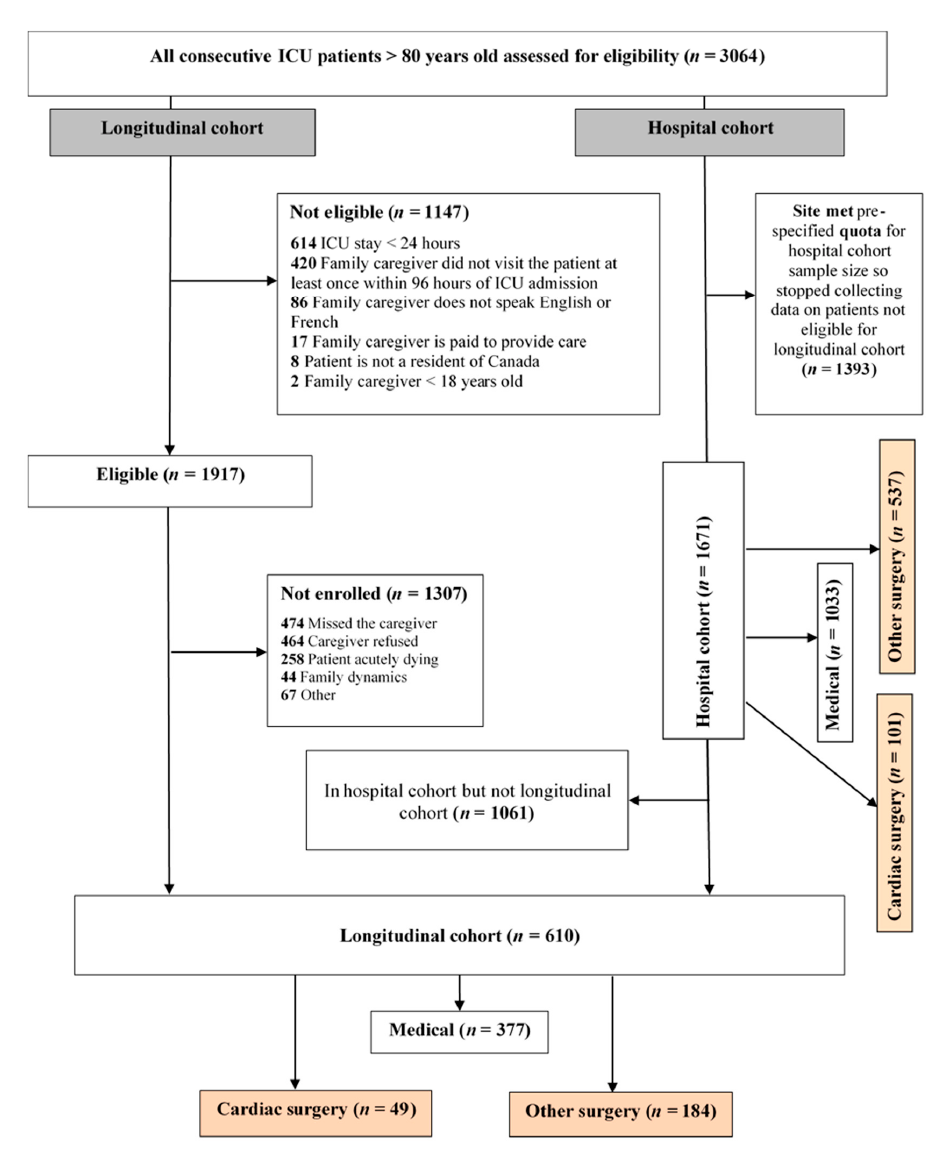
Figure 1. CONSORT Flow diagram, ICU = intensive care unit, CABG = coronary artery bypass graft.